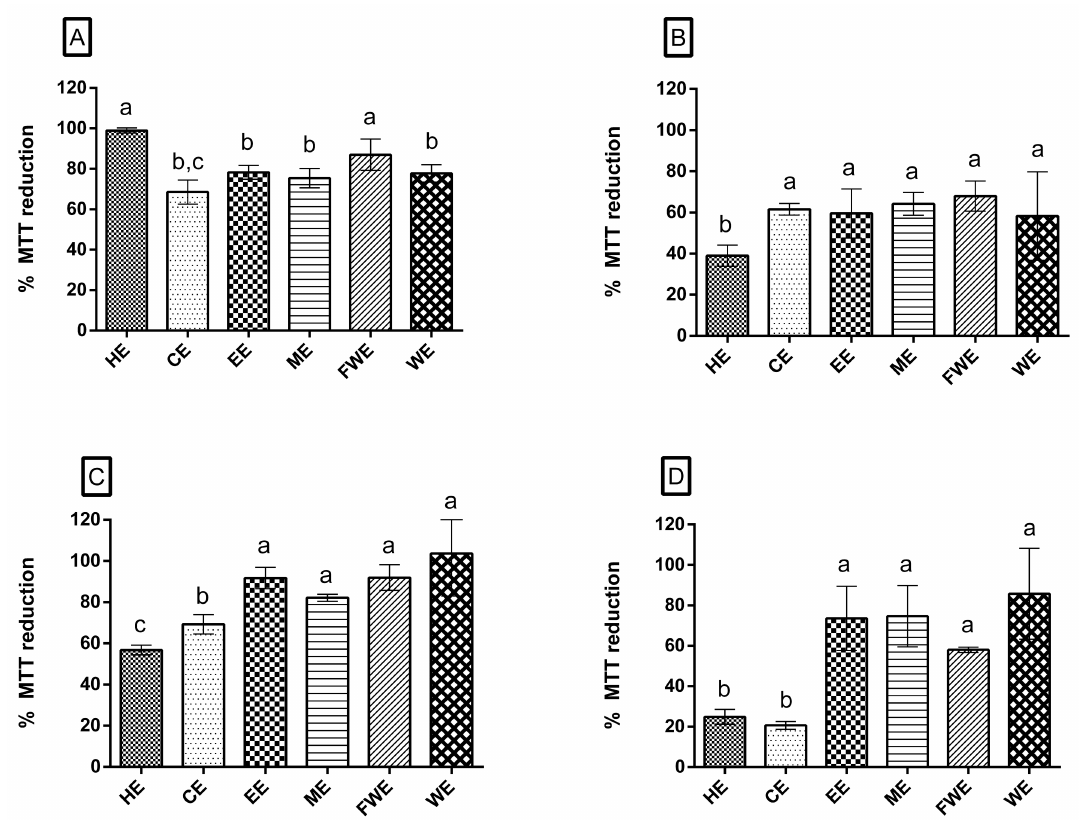
Figure 3. Cell viability. ( A ) Percentage of MTT reduction in 3T3 cells after treatment with M. zehntneri extracts at 250 µg/mL. (B, C, and D) MTT reduction percentage in 3T3 cells after treatment with 250 µg/mL M. zehntneri extracts and 0.1 M H 2 O 2 . ( B ) Preventive effect of M. zehntneri extracts on H 2 O 2 -